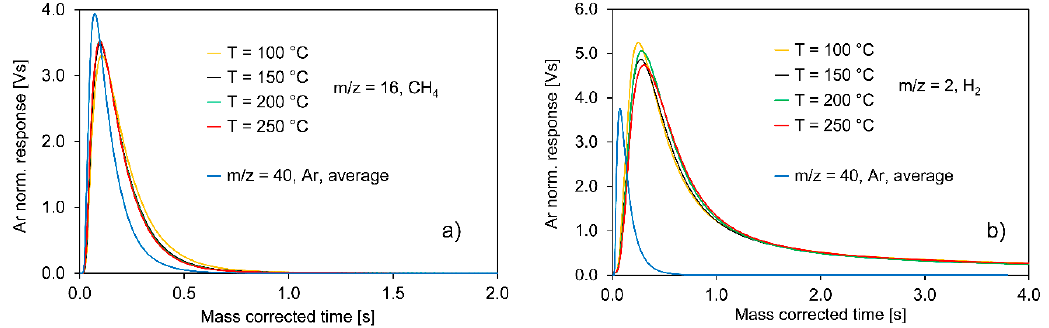
Figure 8. Ar-normalized transient responses of CH 4 and H 2 , respectively, at temperatures between 100 and 250 ◦ C and averaged response pulses of Ar on the Pt / C catalyst to: ( a ) pulses of 50 vol % CH 4 in Ar; ( b ) pulses of 50 vol % H 2 in Ar.